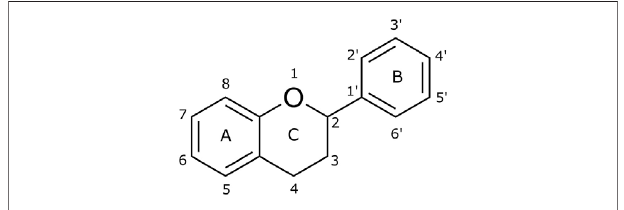
FIGURE 1 | Main structure of fl avonoid, which contains two aromatic rings (A and B) and linked via a heterocyclic ring (ring